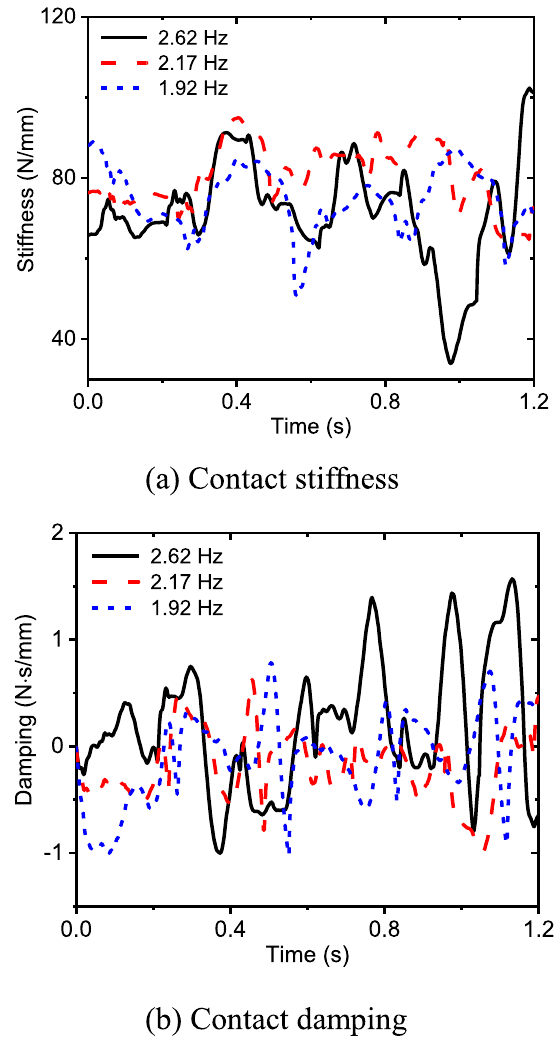
Figure 12 Stiffness and damping estimates in practical experiments